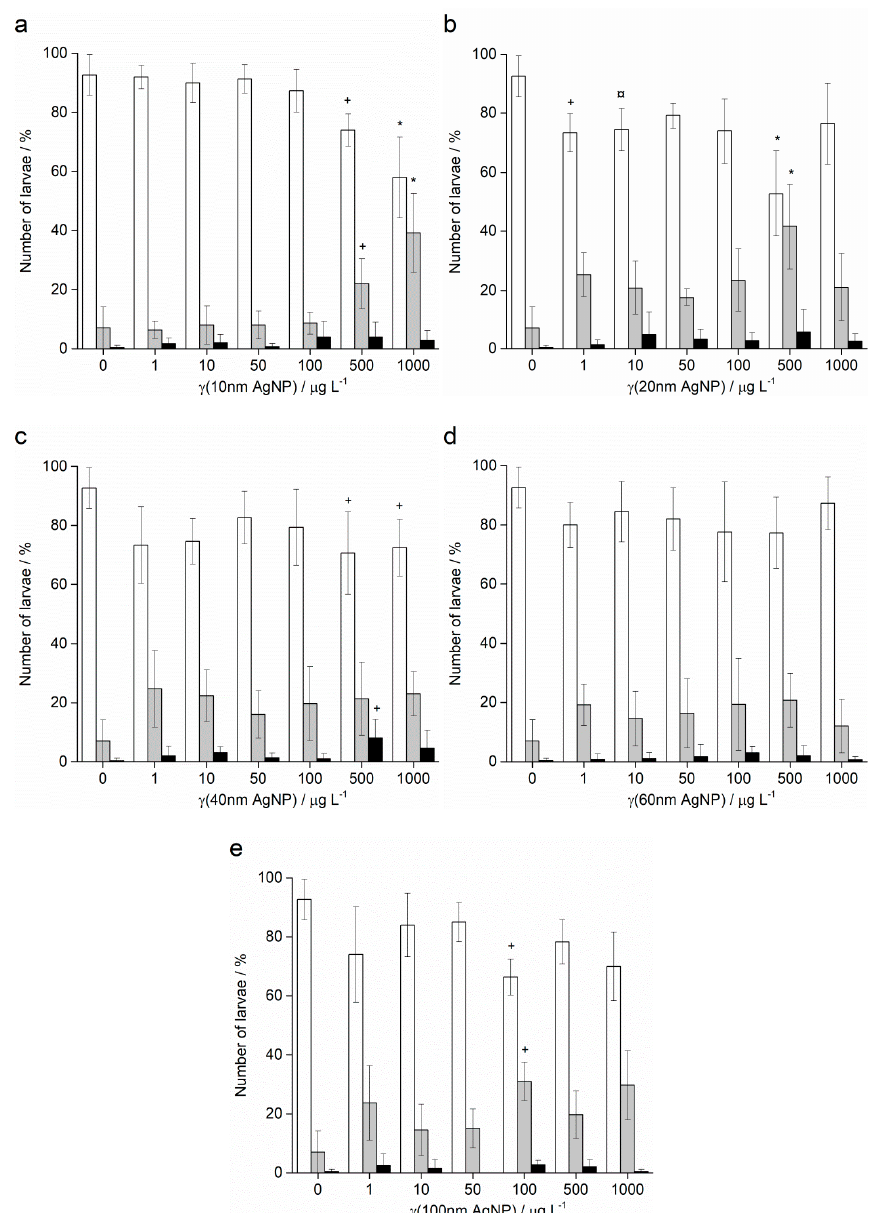
Figure 8. Offspring quality of urchins A. lixula whose sperm was pre-treated for 1 h with different sizes of AgNPs: ( a ) 10 nm, ( b ) 20 nm, ( c ) 40 nm, ( d ) 60 nm and ( e ) 100 nm. White columns indicate normally developed larvae and gray columns developmentally delayed or defective larvae, while black columns show embryos with arrested development (± SD). Significance levels: + p < 0.05, ¤ p < 0.01 and * p < 0.001 (‡ only unfertilised eggs observed). Pre-treatment of sperm with 40 nm AgNPs showed greater effects in offspring (Figure